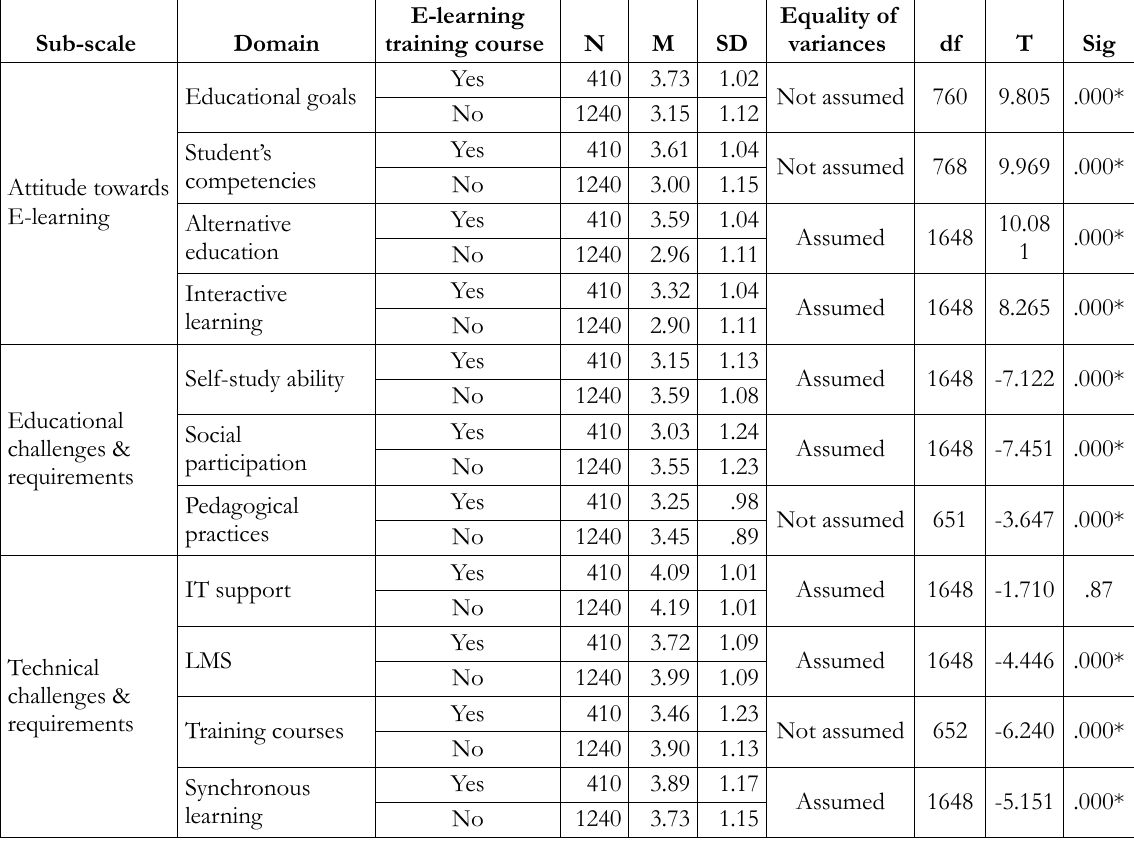
Table 9. Comparing groups of trained undergraduates and untrained undergraduates